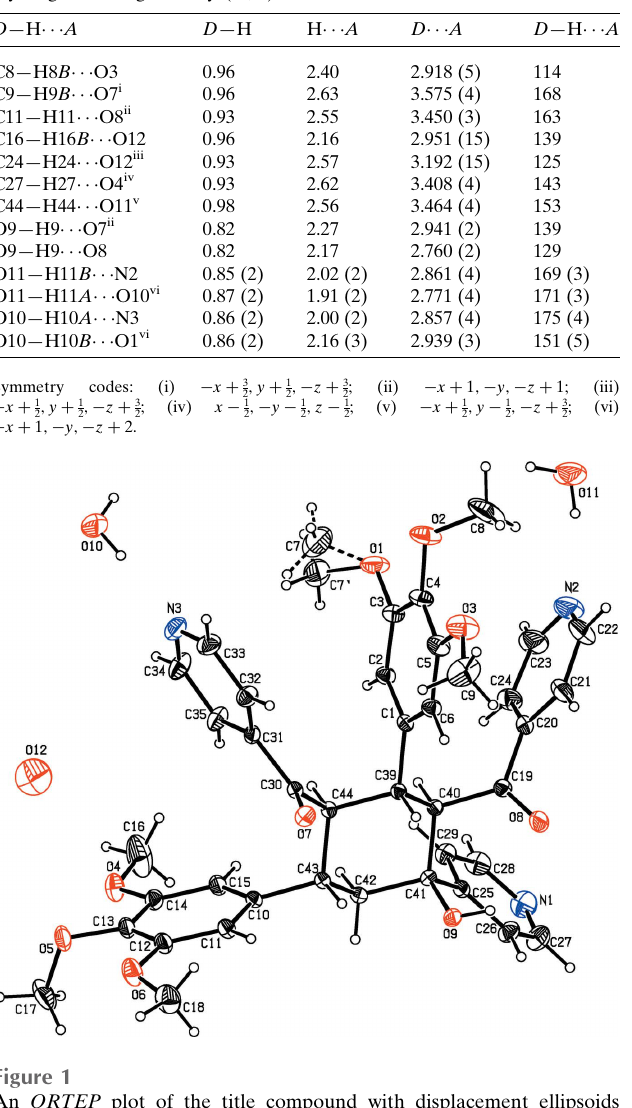
Table 2 Experimental